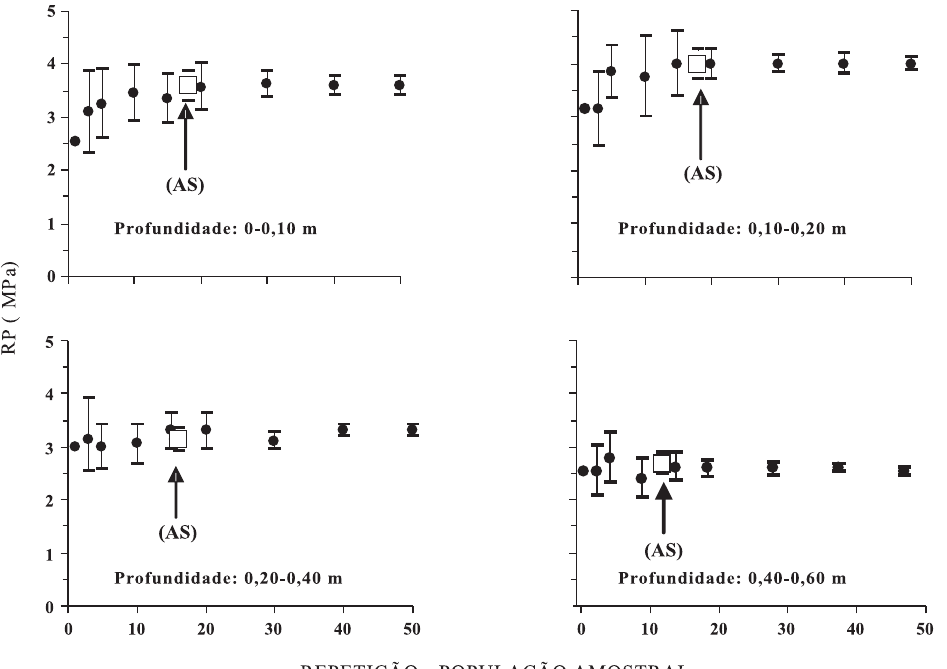
Figura 1. Valores médios e intervalo de confiança (95 %) da resistência do solo à penetração (RP) função da amostragem ao acaso (clássica) e da amostragem sistemática (AS), com penetrômetro de impacto em diferentes profundidades de um Latossolo Vermelho eutroférrico sob plantio direto.